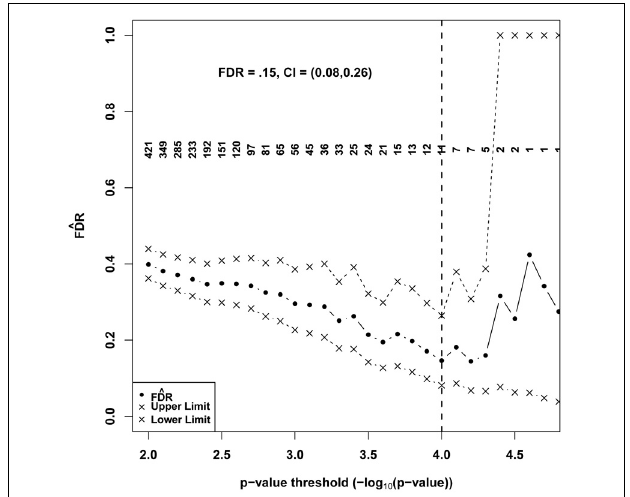
FIGURE 4 | Estimated FDR and 95% CI for a series of significance thresholds applied to 17,404 tests of association between gene expression features and 24h REM sleep. A final set of “significant” genes was identified using a threshold, shown as a vertical black dashed line that corresponded to the minimum F ˆ DR and minimum upper confidence limit. Numbers in the field denote counts of positive tests at the specified p -value significance